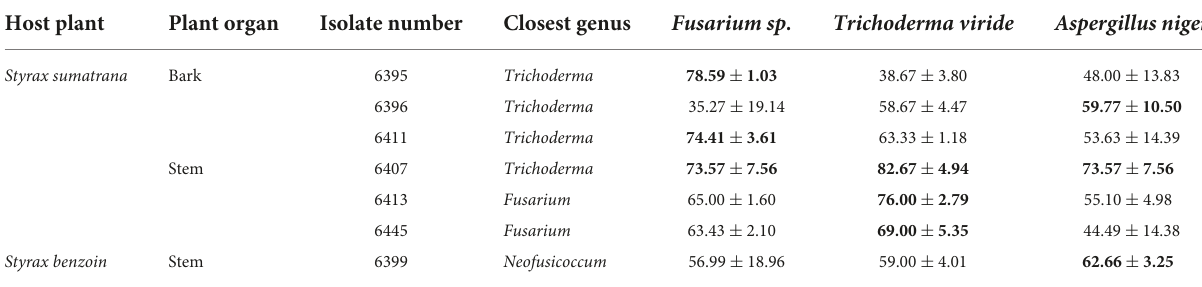
TABLE 1 The high antagonistic activity of endophytic fungal isolates against plant pathogenic fungi, Fusarium sp, Trichoderma viride, and Aspergillus niger using dual culture assay*.